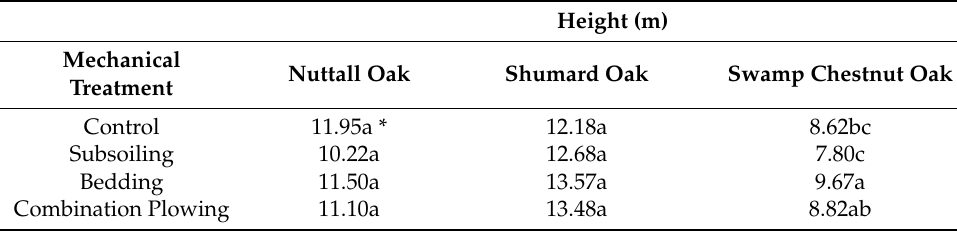
Table 2. Analysis of total height of oak trees by species and mechanical site preparation treatment at 11 years post-planting.